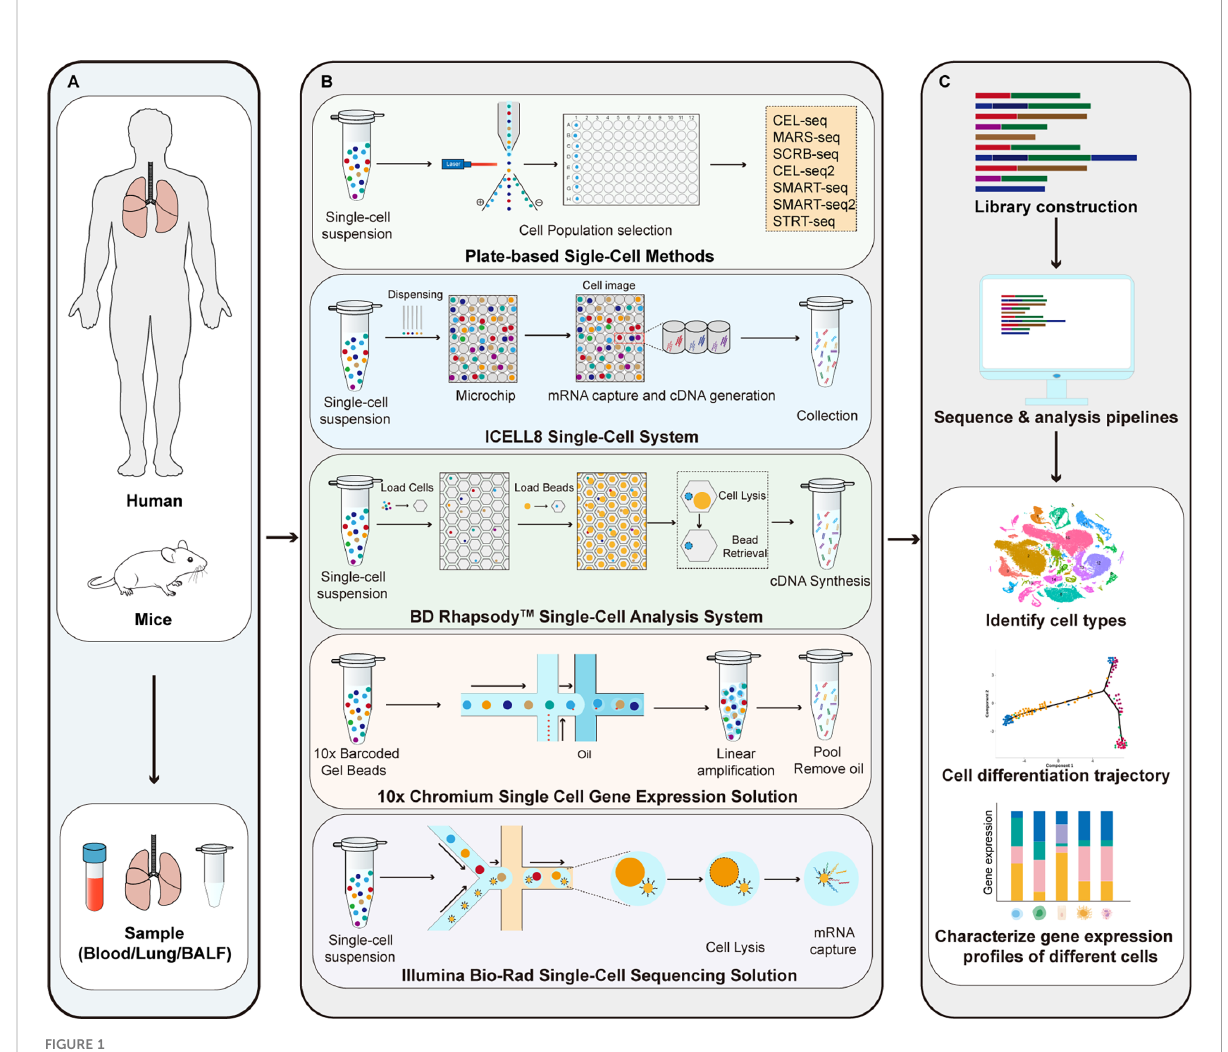
FIGURE 1 Principle of scRNA-seq technologies. (A) Sample preparation; (B) Single-cell library construction and sequencing; (C) Bioinformatics data analysis. CEL-seq, cell expression by linear ampli fi cation and sequencing; MARS-seq, massively parallel single-cell RNA sequencing; SCRB-seq, single-cell RNA barcoding and sequencing; SMART-seq, switching mechanism at 5 ’ end of the RNA transcript; STRT-seq, single-cell tagged reverse transcription